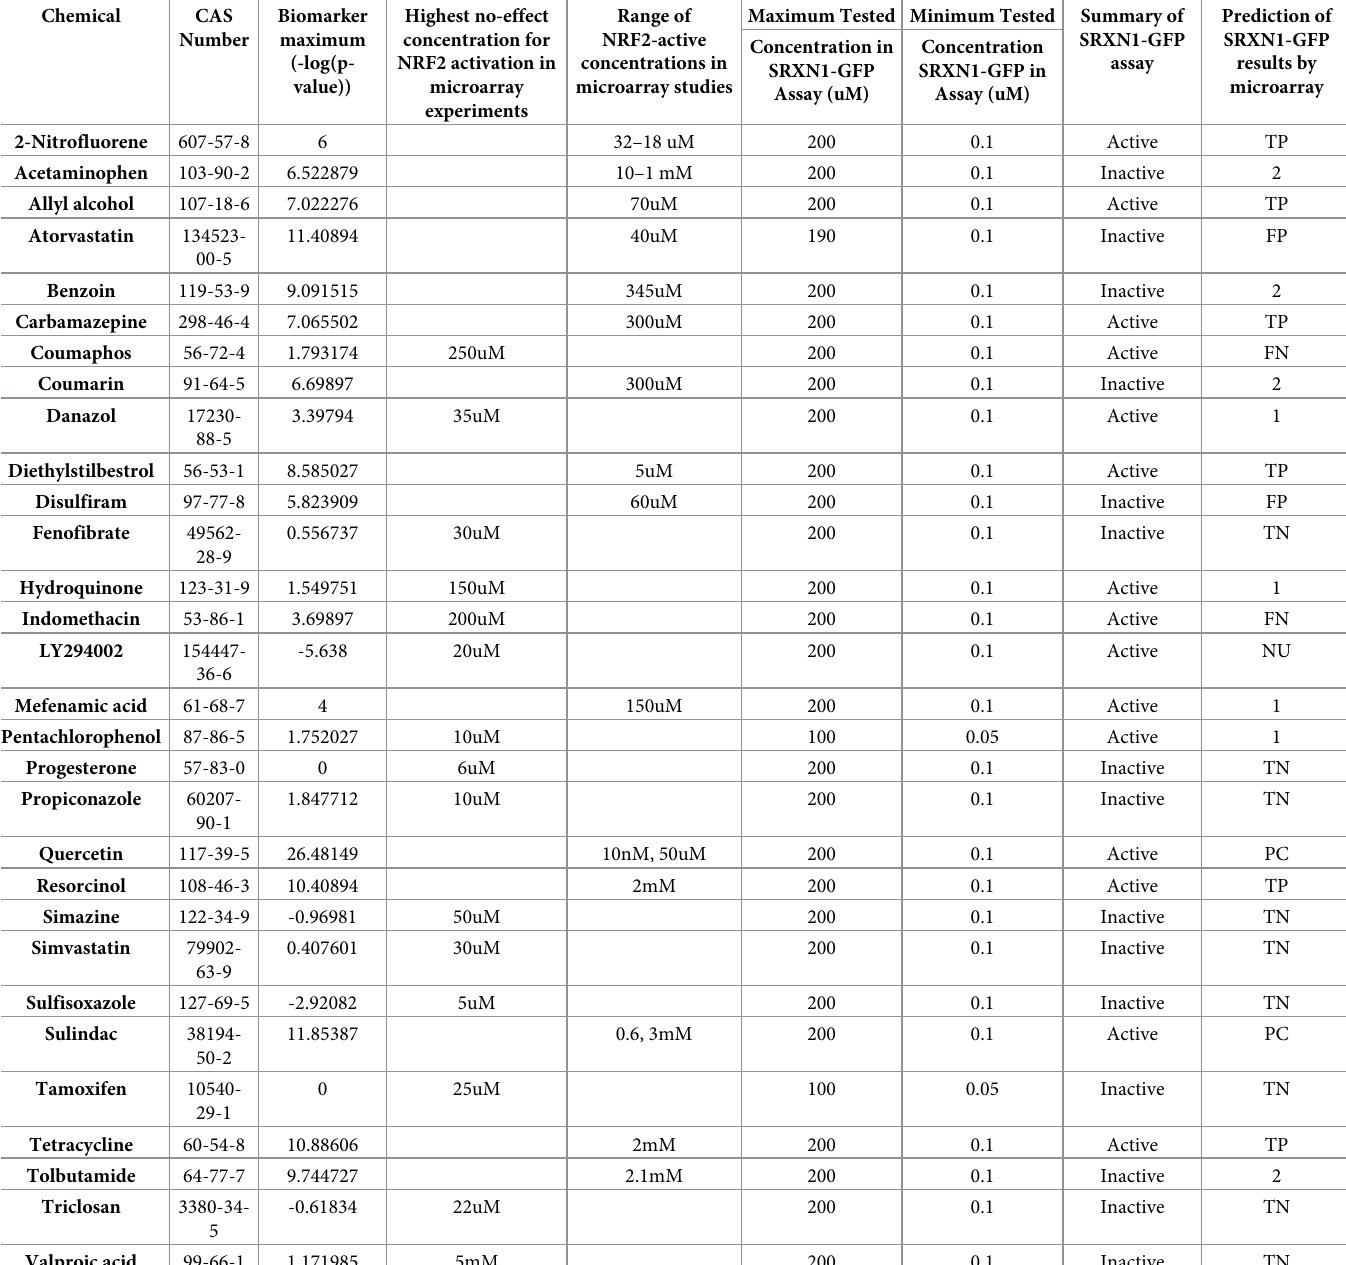
Table 3. Comparison of chemical effects using the biomarker and the SRXN1-GFP assay.